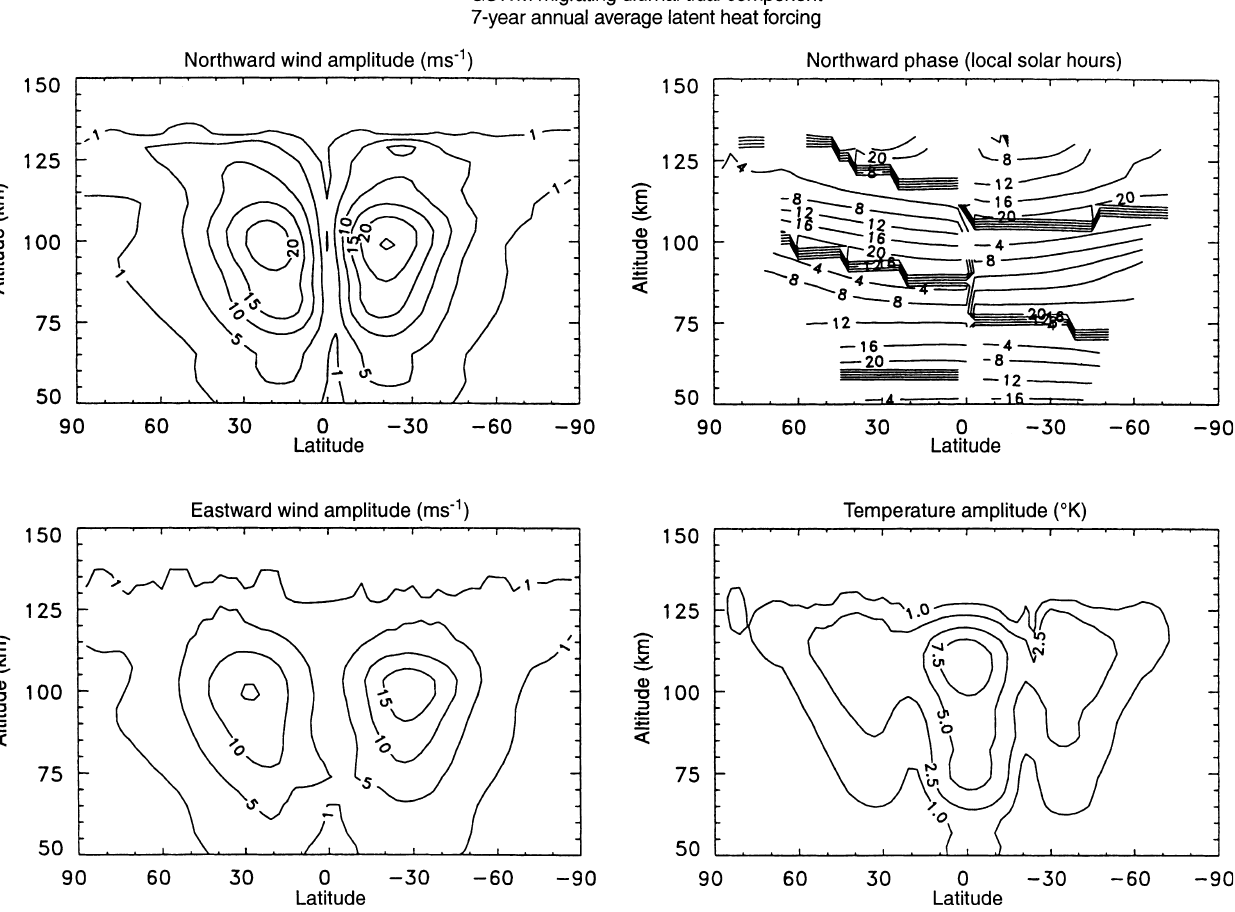
Fig. 6. Diurnal migrating tidal components calculated with the GSWM, with vertical heating specified according to Eq. 2, and latitude distribution and absolute calibration provided by the curves in